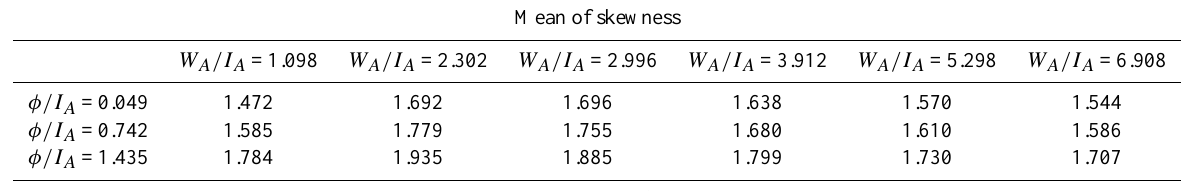
Table 8. Mean and standard deviation of skewness for r L =0.3, r H =0.9; A ranges from 10 to 500km 2 and I 1 ranges from 10 to 50mmh − 1 .